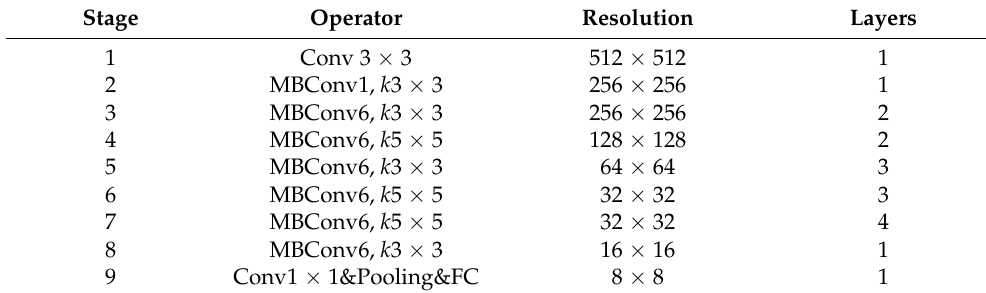
Table 1. Network structure of EfficientNet-b0.